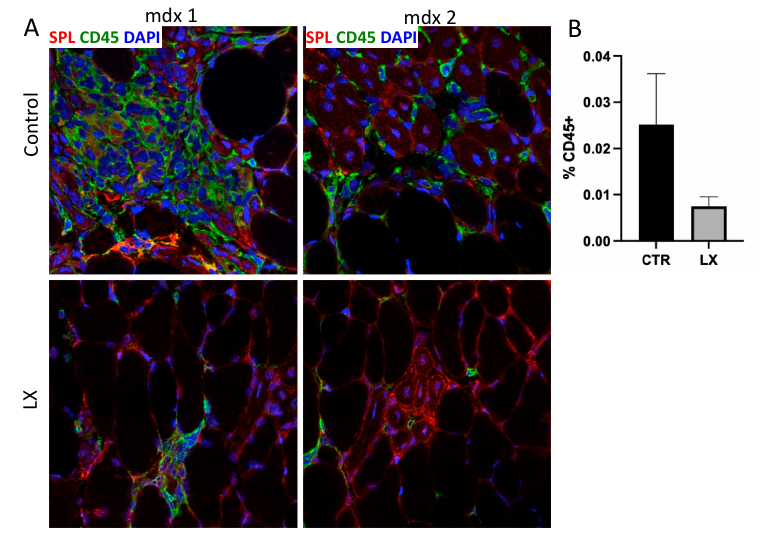
Figure 4. LX2931 perinatal treatment reduces skeletal muscle inflammation in mdx mice. ( A ) Immu- nofluorescence microscopy detecting hematopoietic cell infiltrates in skeletal muscle ( tibialis ante- rior ) of LX2931-treated (LX) and control (CTR) mdx pups. Anti-SPL antibody marks SPL in red. CD45 marks hematopoietic cells in green. DAPI labels nuclei in blue. Muscles from two LX2931- treated (LX) and two control (CTR) mice are shown for comparison. ( B ) Quantitation in percentage of CD45+ fluorescent area/low power field of images in A. ( C ) Neutrophil infiltration in skeletal muscle of LX2931-treated (LX) and control (CTR) mdx pups. Neutrophil elastase (NE) marks neu- trophils in green. DAPI labels nuclei in blue. ( D ) Quantitation of neutrophil elastase of images in C. Magnification = 400×. 2.4. Perinatal SPL Inhibition in Mdx Mice Attenuates Muscle Damage